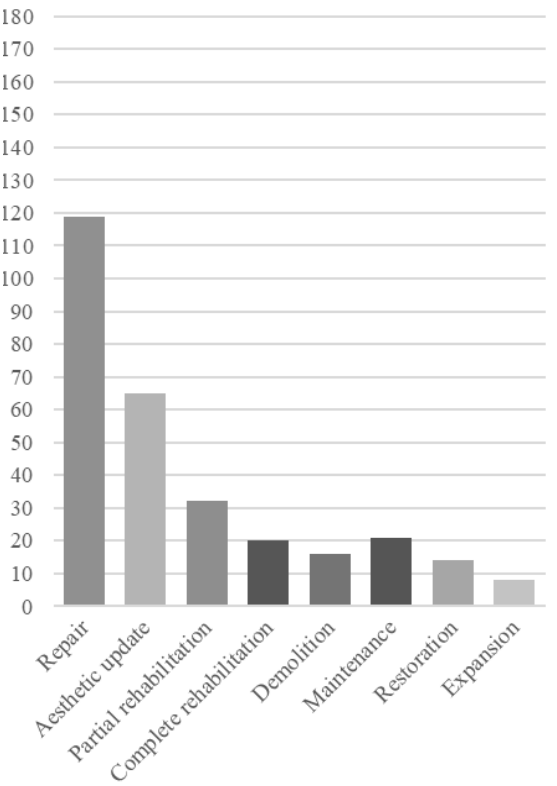
Figure 9. Building in Poza de la Sal (Burgos), partially rehabilitated with new